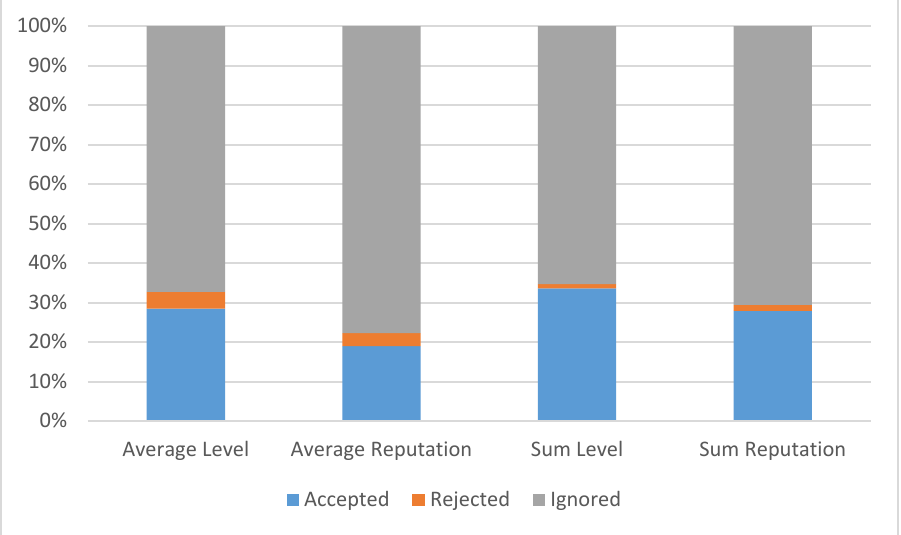
Figure 13. Point assignment strategies